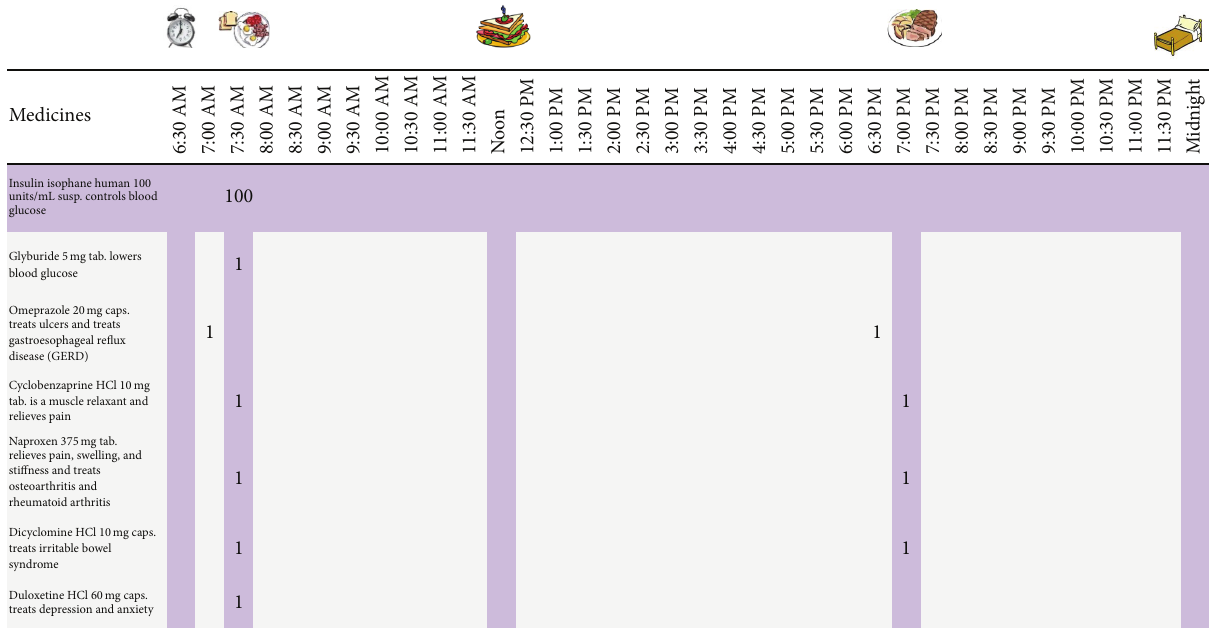
Dicyclomine HCl 10 mg caps. treats irritable bowel syndrome Duloxetine HCl 60 mg caps. treats depression and